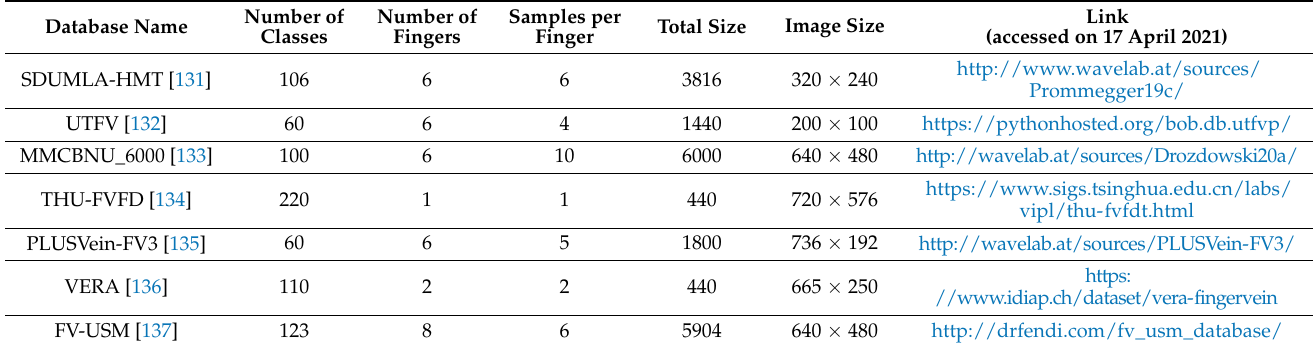
Table 7. Characteristics of the benchmark datasets used in the examined studies.